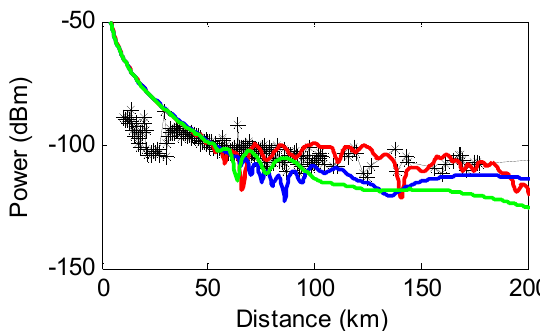
ducts). Figure 11. Comparison of atmospheric duct profiles. Figure 11. Comparison of atmospheric duct profiles.